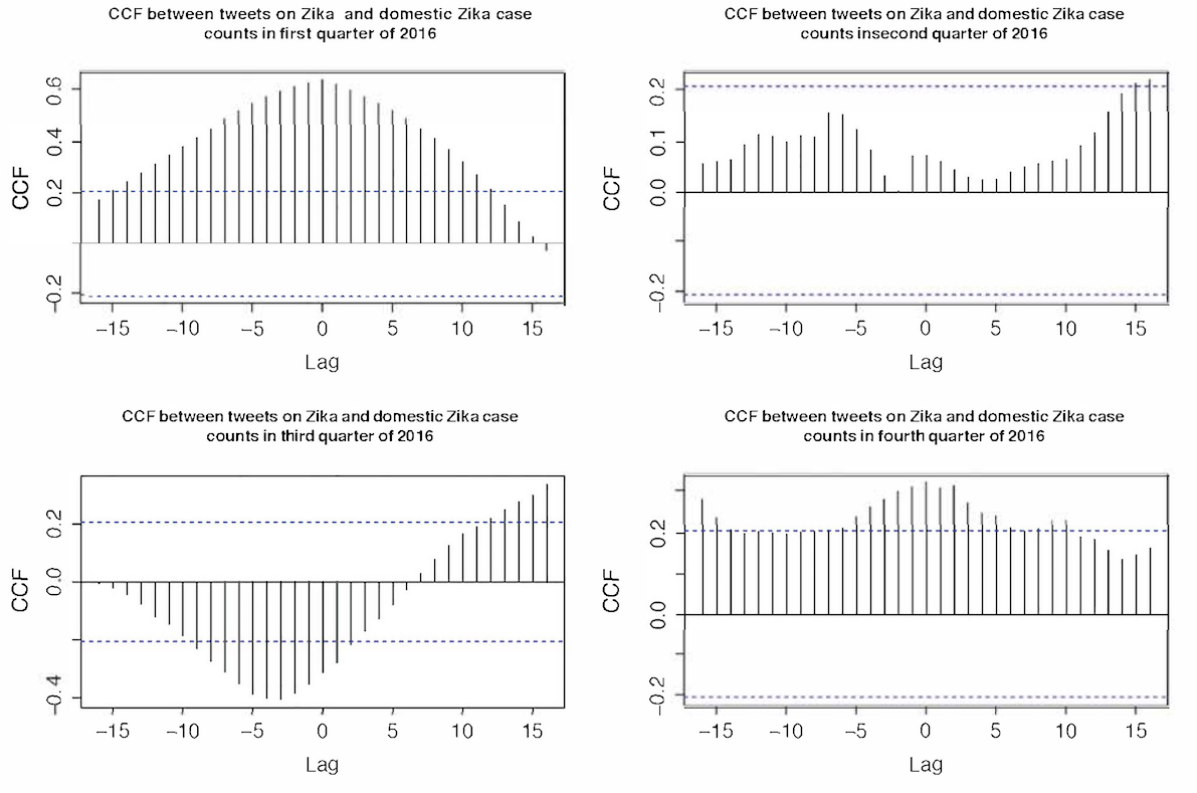
Figure 2. Cross-correlation function between Zika case counts in the domestic United States and tweet counts in 2016. CCF: cross-correlation function.